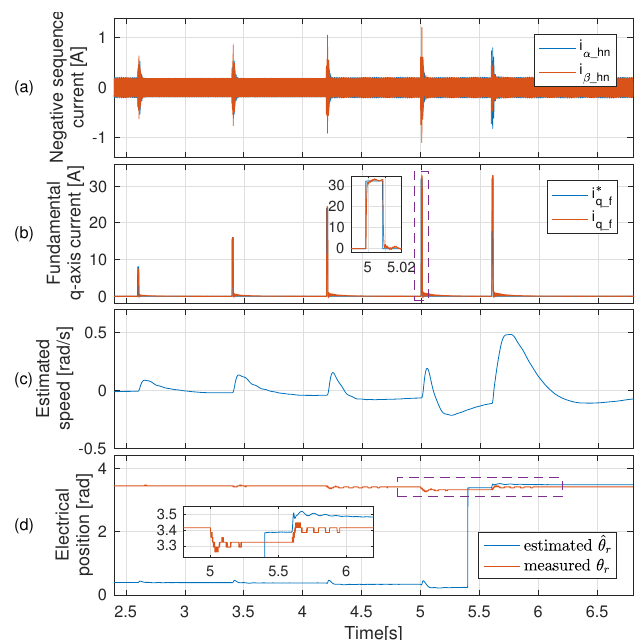
Figure 16. Initial rotor position estimation with inertia load 6 g · m 2 and friction load 0.52 N · m. Table 2. Comparison between the torque-pulse-based method and saturation-based method. Saturation-Based